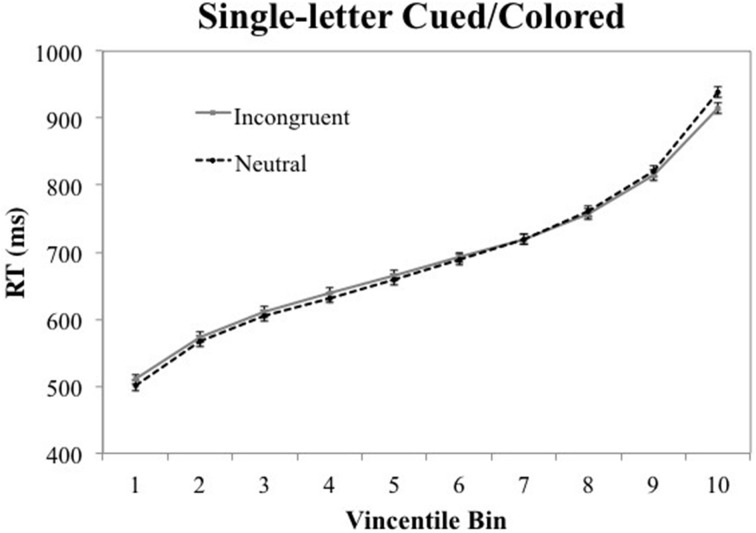
Vincentile RT means for incongruent (i.e., color-associated) vs. neutral stimuli in the single-letter cued/colored condition with 95% confidence intervals.